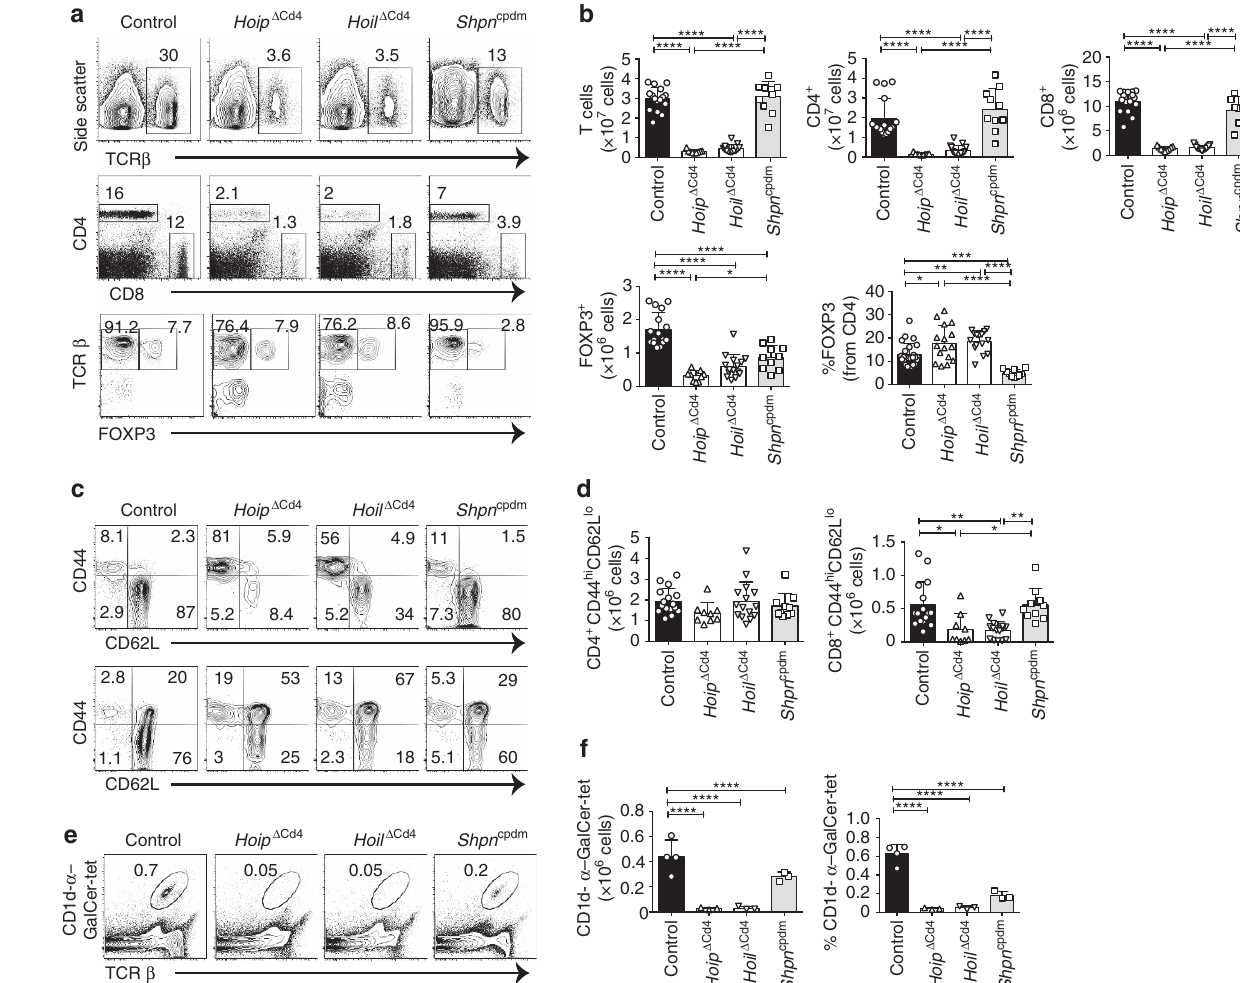
Figure 1 | Absence of HOIP or HOIL-1 causes T-cell deficiency. ( a ) Flow cytometry of splenic cells from 7- to 15-week-old control, Hoip D Cd4 , Hoil D Cd4 and Sharpin cpdm assessed for expression of TCR b (top panels), CD4 and CD8 (middle panels), and for FOXP3, after gating on CD4 þ cells (bottom panels). ( b ) Quantification of CD4 þ CD8 þ TCR b þ and CD4 þ FOXP3 þ cells in the spleen. ( c ) Surface expression of CD44 and CD62L on CD4 þ FOXP3 (cid:2) (top panels) and CD8 þ T cells (bottom panels) in spleens of control, Hoip D Cd4 , Hoil D Cd4 and Sharpin cpdm mice. ( d ) Absolute numbers of CD44 high CD62L low activated cells in the CD4 þ FOXP3 (cid:2) (left graph) and CD8 þ (right graph) populations from the spleens of controls, Hoip D Cd4 , Hoil D Cd4 and Sharpin cpdm mice. ( e ) Flow cytometry of splenic CD1d- a GalCer tetramer-positive NKT cells from 7- to 15-week-old control, Hoip D Cd4 , Hoil D Cd4 and Sharpin cpdm mice. ( f ) Total cell numbers and percentages of CD1d- a -galactosylceramide ( a -GalCer) tetramer-positive NKTcells in the spleen. For b , d and f , each symbol represents an individual mouse; small horizontal lines indicate mean ± s.d.; * P o 0.05, ** P o 0.01, *** P o 0.005 and **** P o 0.001, respectively. One-way analysis of variance with a Tukey’s post-hoc test for multiple comparisons was used for statistical analysis. Shpn cpdm refers to Sharpin cpdm mice. Data are pooled from six independent experiments with two to six mice per group ( a – d ) or representative of two independent experiments with three to six mice per group ( e , f